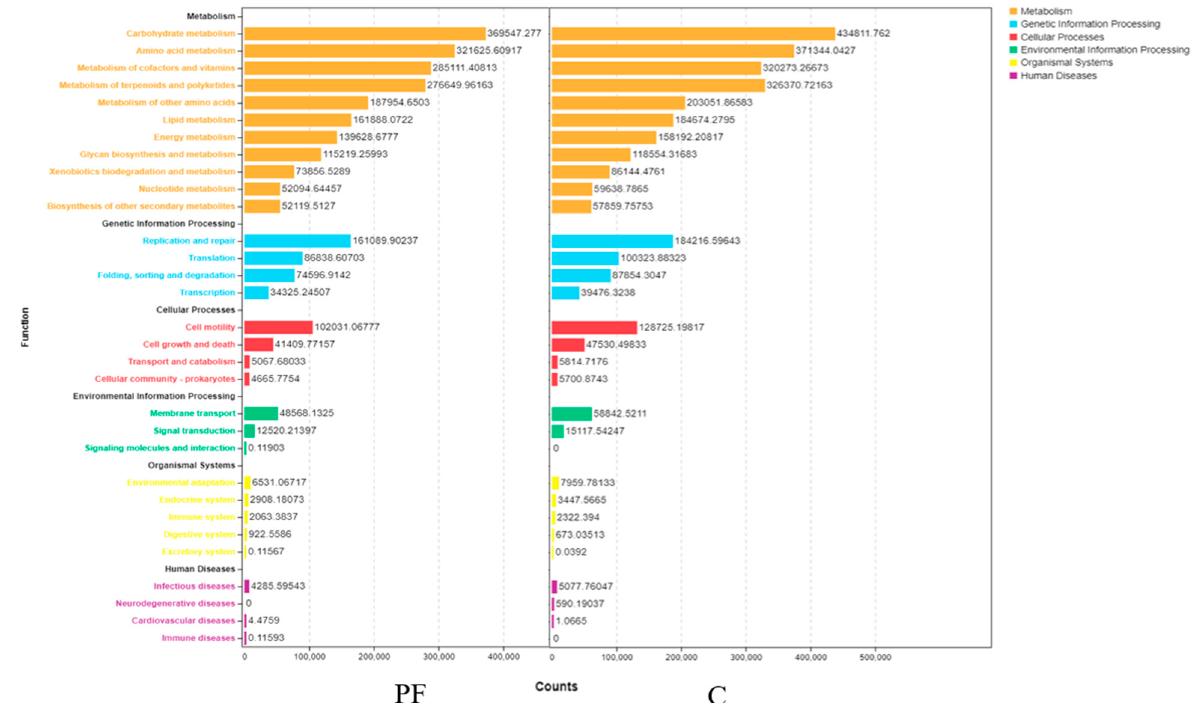
Figure 6. Function distribution stack based on PICRUSt2 of group C ( right ) and group PF ( left ).